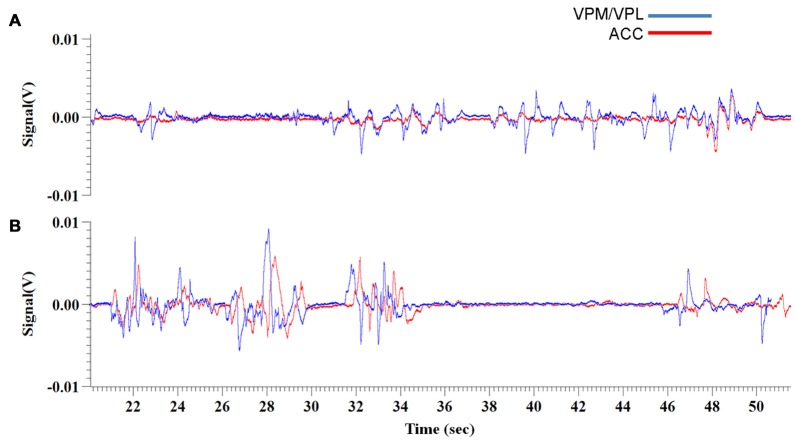
Experiment 3, representative raw traces of LFP recordings from the VPM/VPL thalamus and ACC 1 week and 2 weeks post-VZV injection (A,B, respectively). The representative traces show recordings from 20 min to 50 min of the 70 min total recording time.